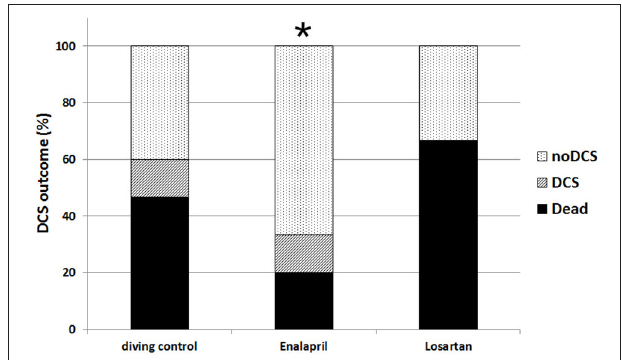
FIGURE 1 | Appearance of DCS among control rats and rats treated with enalapril and losartan. Appearance of DCS among the control rats and rats treated with enalapril and losartan expressed as a percentage of the total number of the rats in each group. Histogram in black represents the rats suffering severe DCS, stripes are rats with mild DCS and dots are the asymptomatic group * p < 0.05.